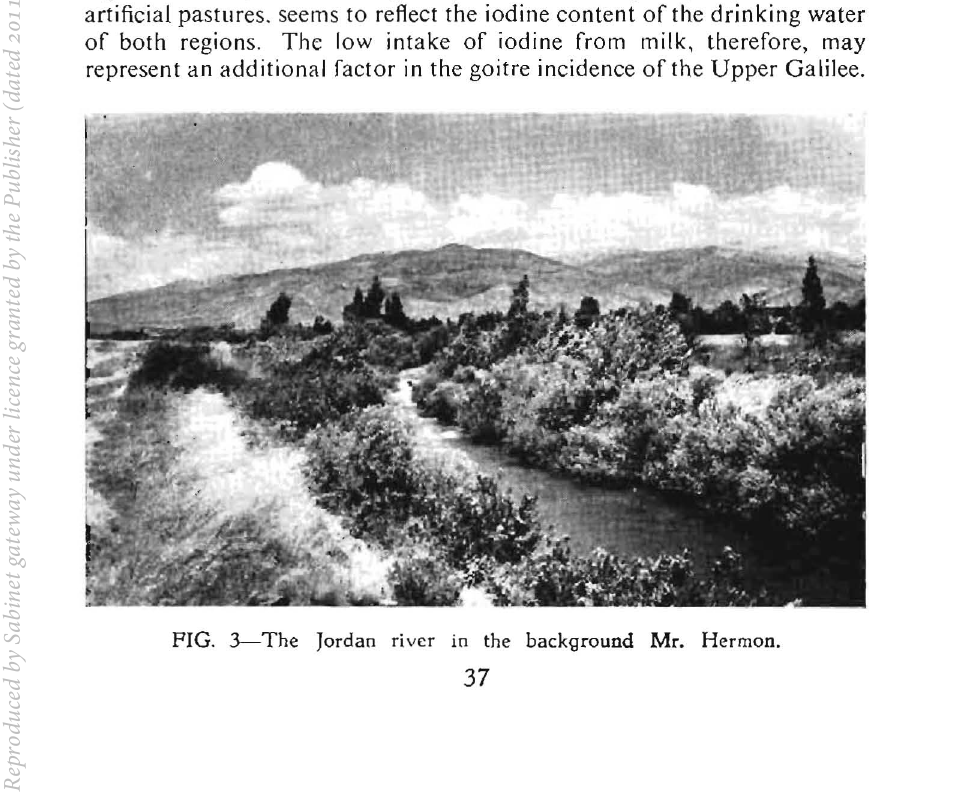
FIG. 3- The Jordan river in the background Mr.